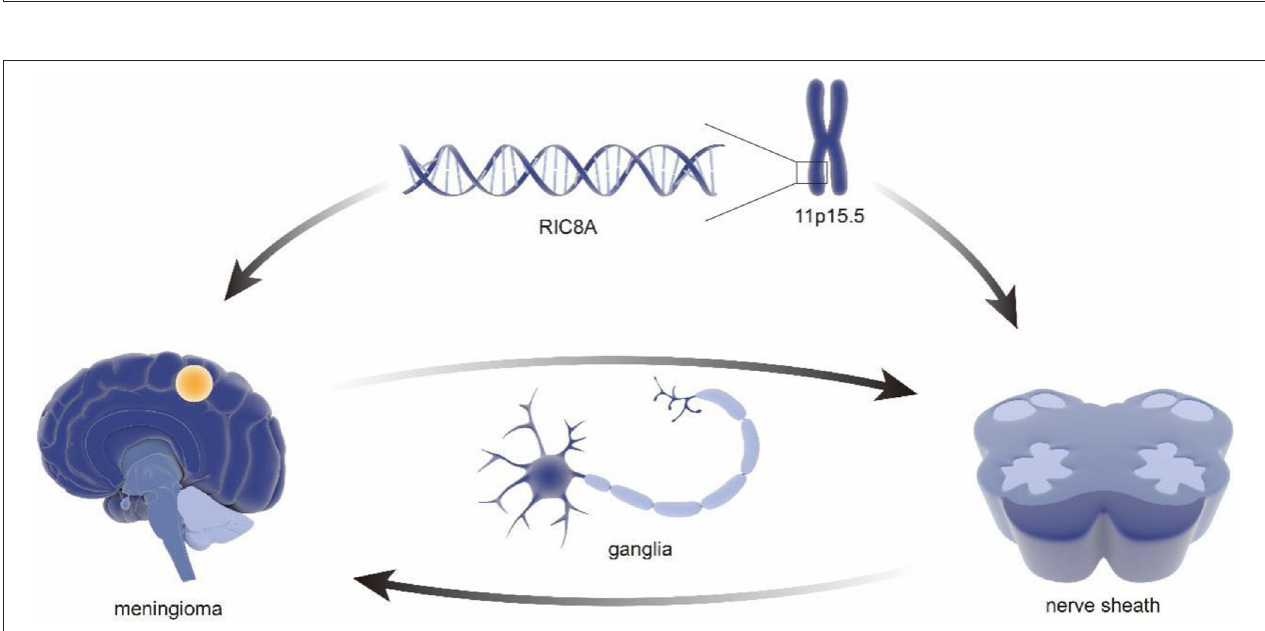
FIGURE 2 | Genetic association of the nerve sheath development and meningioma. The RIC8A located in area 11p15.5 were revealed to be associated with pathological phenotypes in meningioma. It is important to mention that the same genes have been confirmed to be related to cranial neural crest-derived structures. Consider the correlation between nerve sheath and ganglia, which might explain a series of cases of nerve sheath meningioma and ganglia intraparenchymal meningioma.